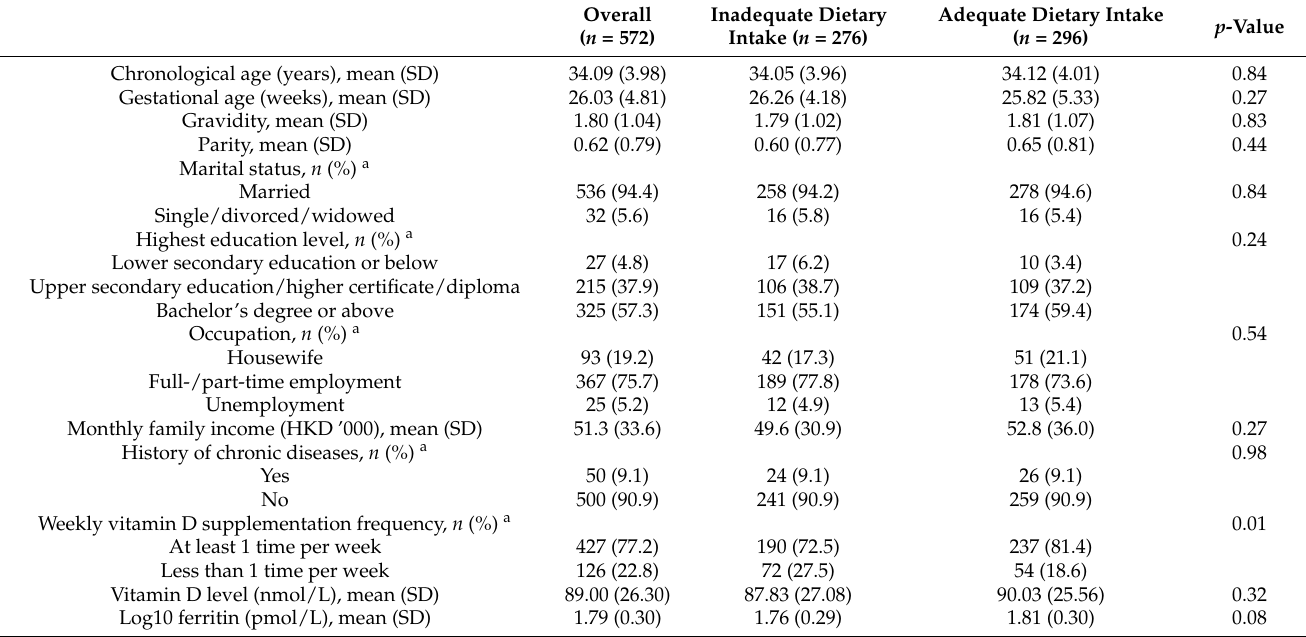
Table 1. Participant